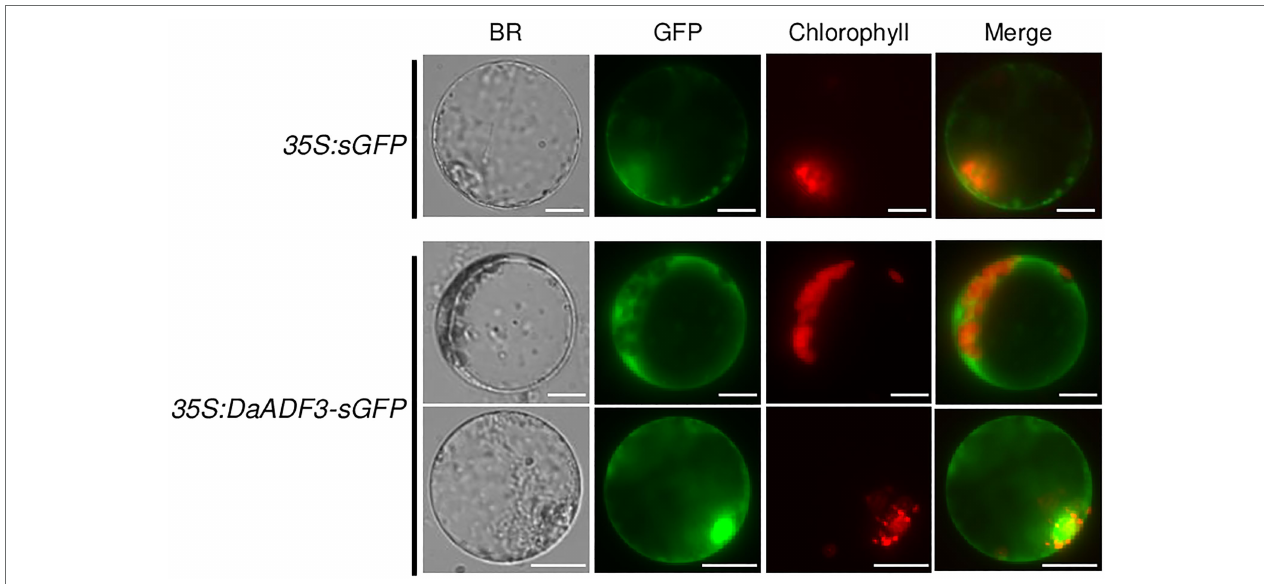
FIGURE 4 | Subcellular localization of DaADF3. The 35S:DaADF3-sGFP fusion construct was transfected into protoplasts prepared from mature leaves of D. antarctica . Fluorescent signals of the expressed proteins were visualized by fluorescence microscopy. sGFP was used as a cytosolic marker protein. Bars = 20 μ